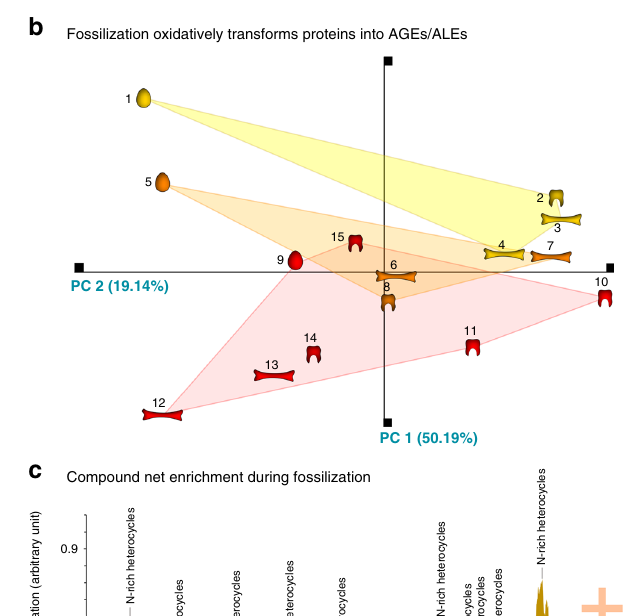
Fig. 4 Chemospace and dissimilarity plot showing chemical similarity between modern, matured and fossil samples. a Chemospace including control samples (sediments, undecalci fi ed samples from reducing settings, glues, epoxy resin; a total of 28 specimens). b Chemospace excluding control samples (a total of 15 specimens). Colored clusters represent the three main categories of samples analyzed in this study: control samples (gray), modern (yellow), experimentally matured (orange) and fossil hard tissues (red). 1 Rhea americana eggshell; 2 Lepisosteus osseus scale; 3 Gallus domesticus eggshell; 4 Alligator mississipiensis bone; 5 Rhea americana eggshell matured; 6 Gallus domesticus matured; 7 Alligator mississipiensis bone matured; 8 Lepisosteus osseus scale matured; 9 Heyuannia huangi eggshell; 10 Miohippus anceps tooth; 11 Allosaurus fragilis tooth; 12 Psammornis rothschildi eggshell; 13 Allosaurus fragilis bone; 14 paleonisciform scale; 15 paleonisciform scale; 16 crocodilian bone; 17 Iguanodon bernissartensis bone; 18 sediment surrounding Diplodocus bone; 19 epoxy resin; 20 sediment surrounding Maiasaura sp. remains; 21 Maiasaura sp. tooth; 22 sediment embedding Ichthyosaurus bone; 23 polyacrylamide glue; 24 Ichthyosaurus sp. bone; 25 Maiasaura sp. eggshell; 26 polyacrylamide glue on fossil bone; 27 Saltasaurus sp. eggshell; 28 Nothosaurus sp. tooth. c Dissimilarity plot illustrating soft tissue compositional changes through fossilization. An average Raman spectrum based on all fresh soft tissues (a total of 4 specimens acquired with 4 accumulations) was subtracted from that based on all fossil soft tissues analyzed (a total of 7 specimens acquired with 4 accumulations). The spectral bands indicating the net enrichment of proteinaceous soft tissues during fossilization correspond to pentosidine (depicted), a classic AGE/ALE